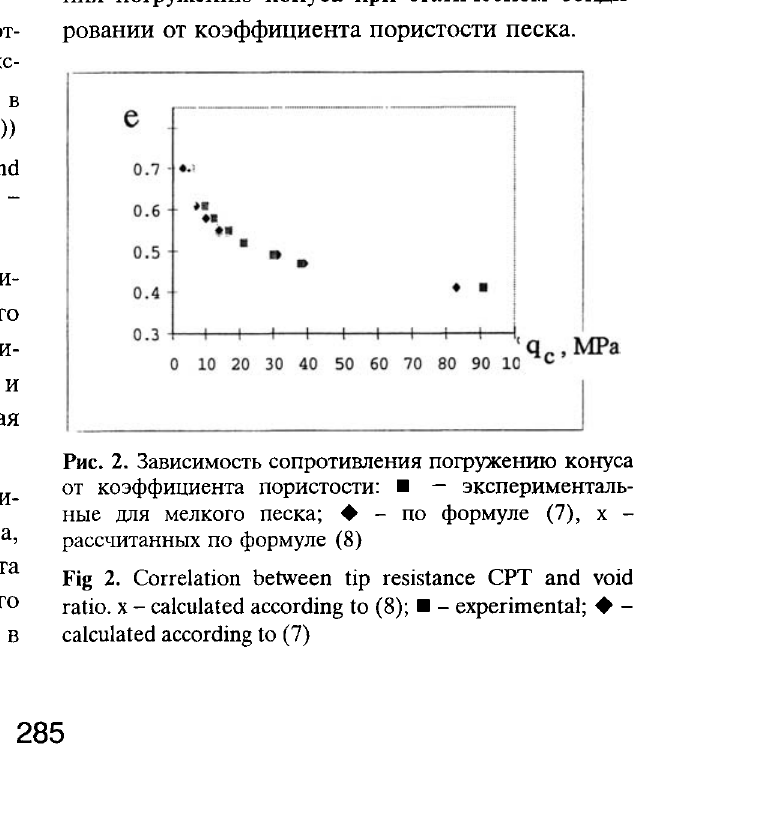
Fig 1. Corelation between void ratio natural fine sand and void ratio compacted fine sand.